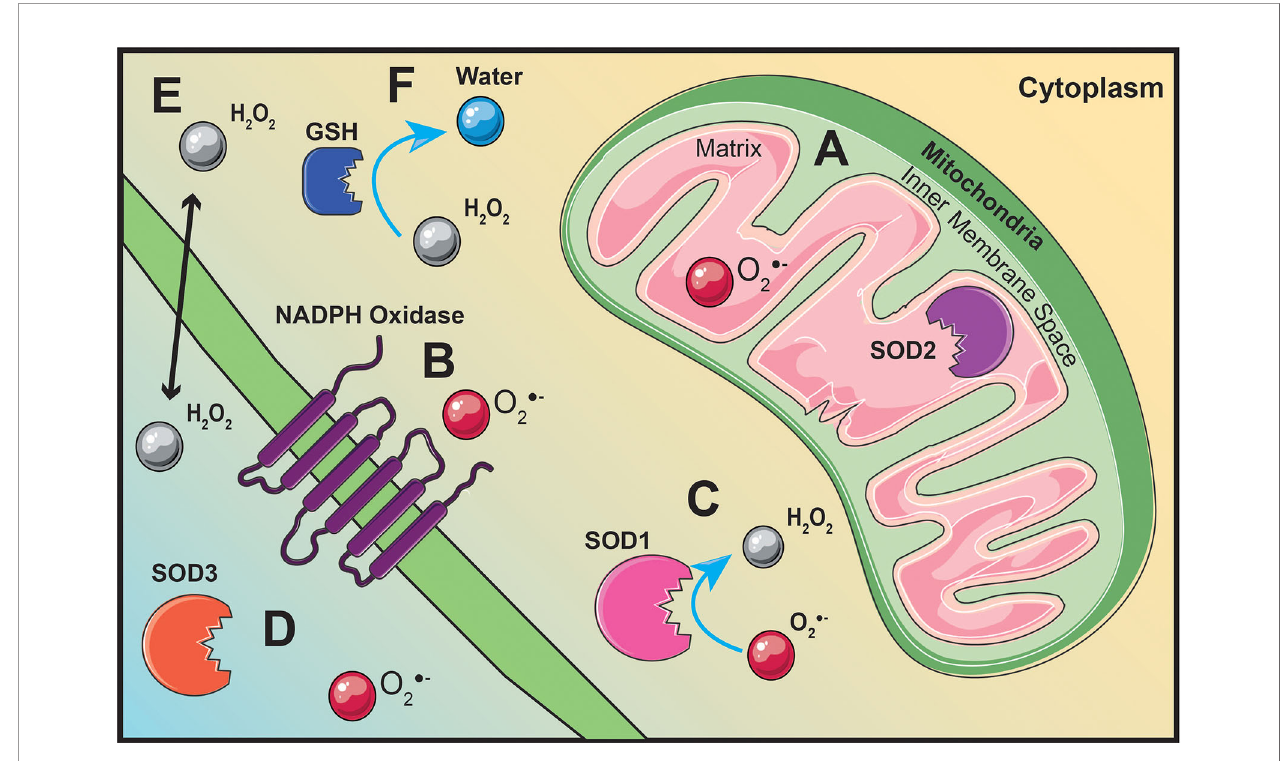
FIGURE 3 | ROS production originates from various locations throughout the cell. Superoxide is generated within the mitochondrial matrix (A) or by membrane bound NADPH oxidases (B) . Superoxide dismutase (SOD) located within the mitochondrial matrix (A) , within the cytoplasm (C) , or extracellularly (D) will convert superoxide into hydrogen peroxide (H 2 O 2 ) (C) . Hydrogen peroxide is able to act as signaling molecule within the cell or extracellular due to its ability to diffuse across the cell membrane (E) . Glutathione (GSH), located throughout the cytoplasm, will regulate hydrogen peroxide levels by converting hydrogen peroxide into water (F)